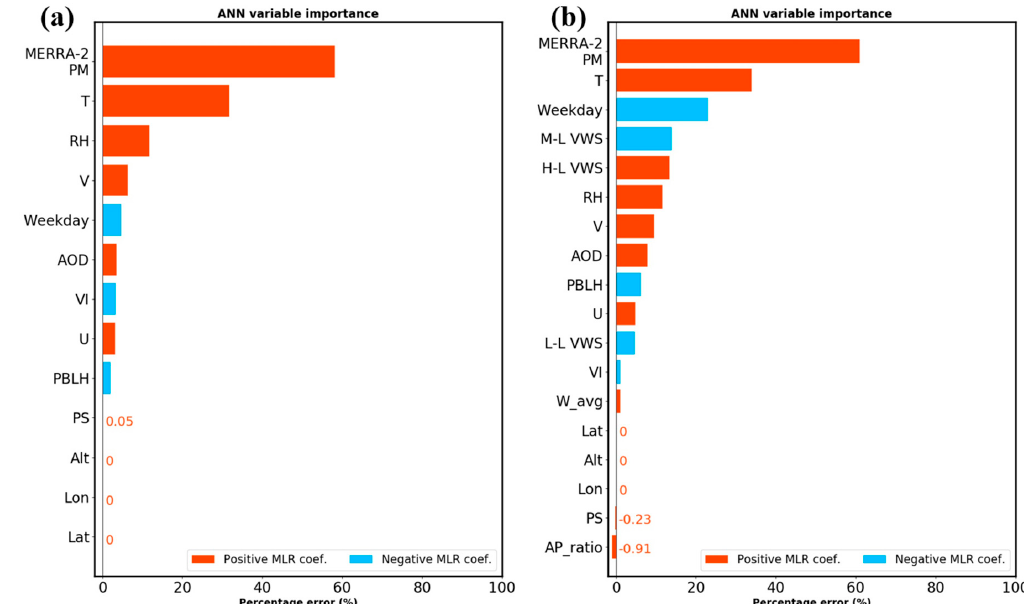
Figure 7. Variable importance of ( a ) set 1 and ( b ) set 2 models at Rockland County site. Values indicate the permutation importance estimated from the ANN models, and colors indicate the signs of regression coefficients in the MLR models.